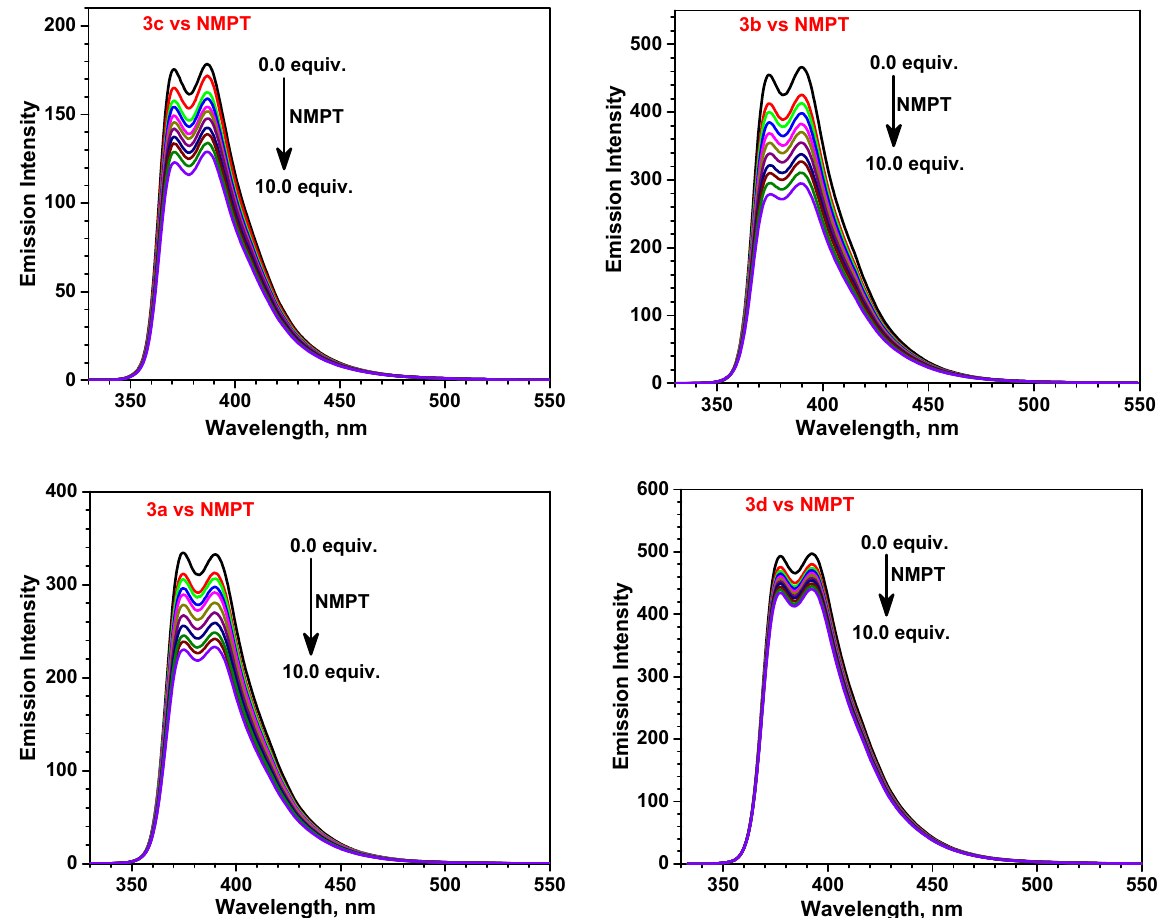
Figure 4. Fluorescent spectra of carbazole-appended calixarenes 3a – d (DCE, 10 µM) with various concentrations of NMPT, 2 (0 to 10 equivalents). Excitation wavelength 321 nm.